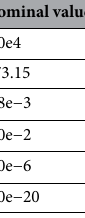
Table 2. Typical solidification parameters for an object in front of an ice-water solidification front. σ sl adapted from Rempel et al. 16